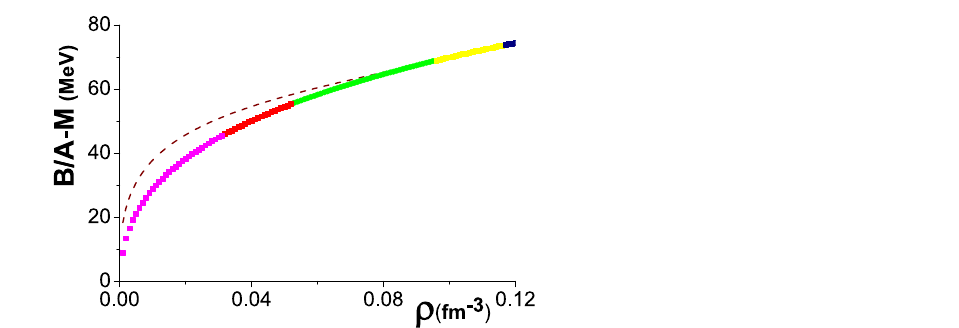
Figure 14. npe matter binding energy obtained with the CP method and NL3 parametrisation [45]. Figure taken from [96].